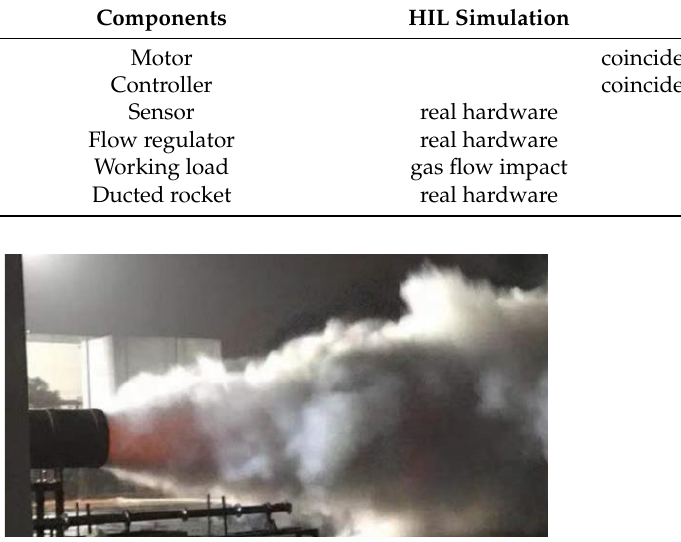
Figure 13. Hardware in loop simulation system for the ducted rocket [12] ① Flow Regulator valve; ② Flow Regulator Motor; ③ Controller; ④ Load Simulation Device; ⑤ Real-Time Simulation Device; ⑥ Simulation Station; ⑦ Ground Test Device; ⑧ Sensor Cable; ⑨ System Power. Table 1. Comparison between the HIL simulation and direct-connected ground test.